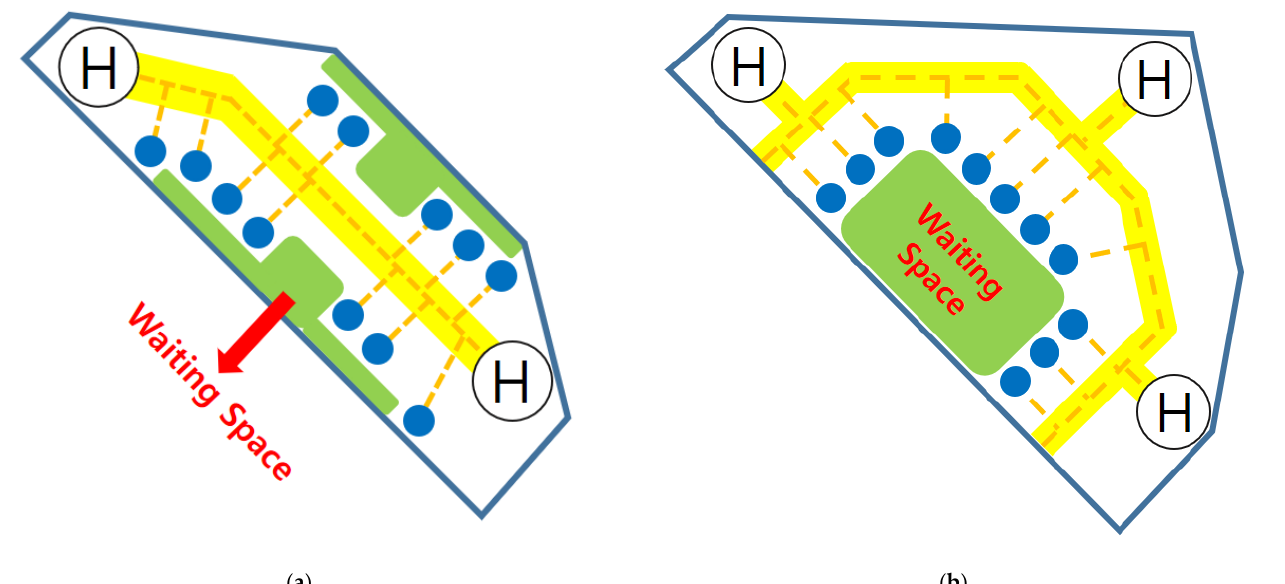
Figure 21. Pier topologies for the Gimpo Airport parking lot that comply with the FAA’s new regu- lations: ( a ) current parking space; ( b ) expanded parking space.